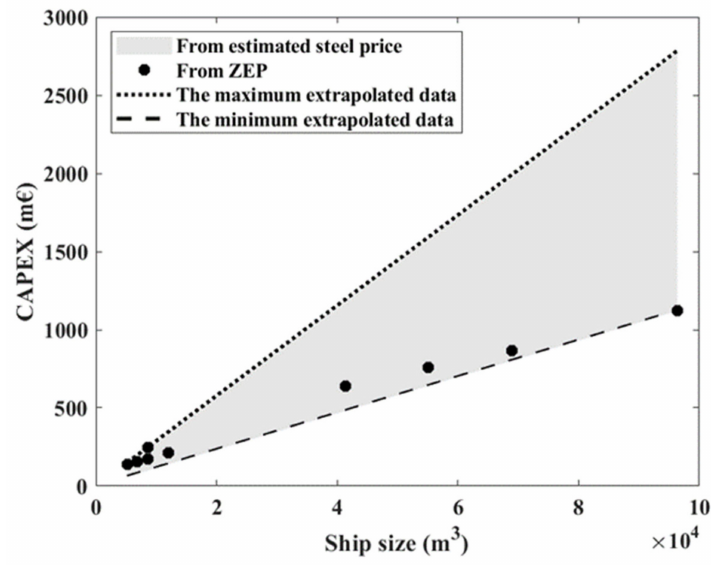
Figure A1. CAPEX of the crew ship in comparison with ZEP report results.